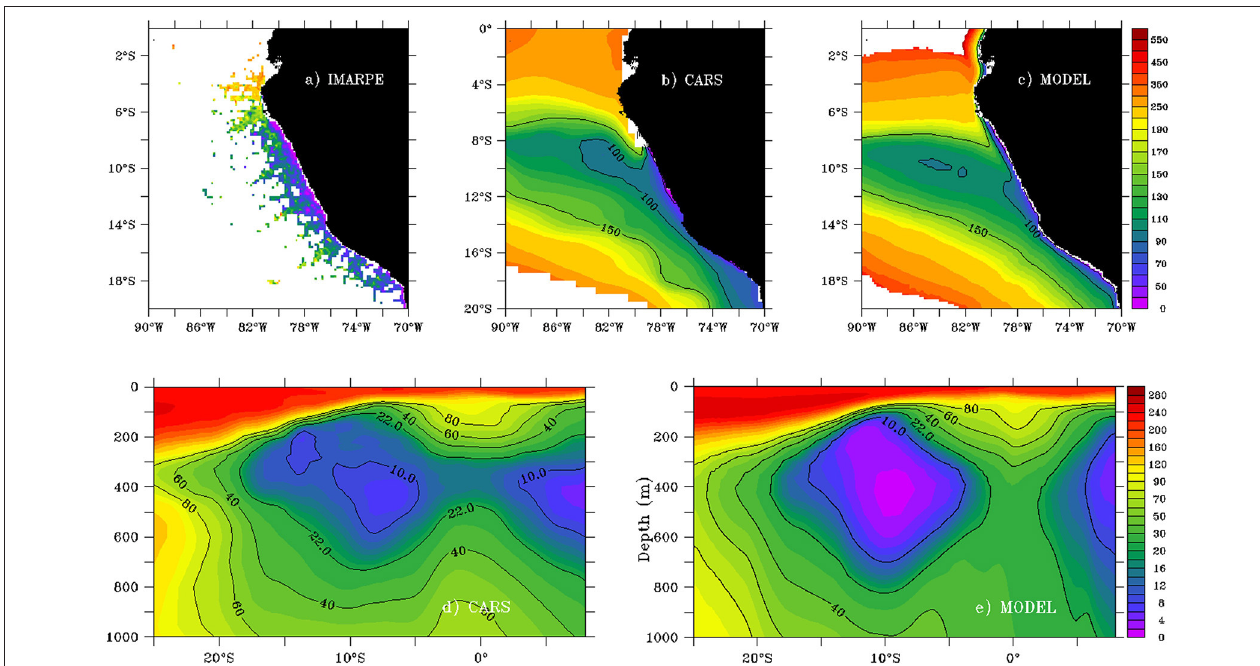
FIGURE 2 | Annual ZO2 mean (in meters) from IMARPE (a) , CARS (b) and model (c) . Meridional section (86 ◦ W) of the annual DO mean (in µ mol kg − 1 ) from CARS (d) and model (e) . Annual means were computed over 1958–2008 using the model and IMARPE data.